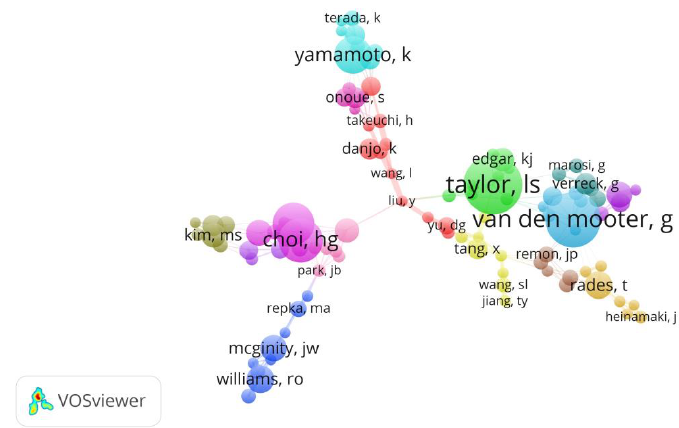
Figure 7. Mapping of authors’ cooperation network. The size of node represents the author’s publication number and the link strength between two nodes means the collaboration intensity between authors.